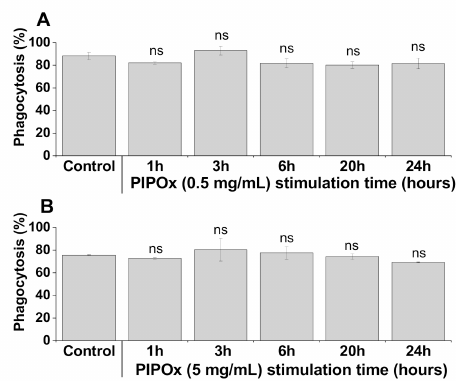
Figure 6. RAW 264.7 macrophage phagocytosis of C. albicans –FITC (%) following treatment with PIPOx analyzed by flow cytometry. The phagocytosis of FITC-labeled C. albicans cells by RAW 264.7 macrophages was analyzed by pre-treatment of cells for 1, 3, 6, 20, and 24 h with 0.5 mg/mL ( A ), and 5 mg/mL ( B ) of PIPOx and subsequent phagocytosis test analyzed using flow cytometry. Control represents untreated cells (Control). All data are expressed as Mean ± SD. Tests were carried out in triplicate. The one-way ANOVA and post hoc Bonferroni’s tests was used to determine statistical significance of differences between untreated and stimulated cells and is expressed as ns— p >